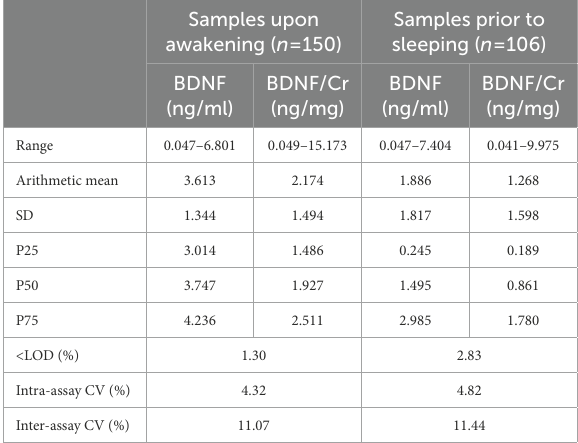
TABLE 3 Urinary BDNF concentrations in adolescent males (15– 17